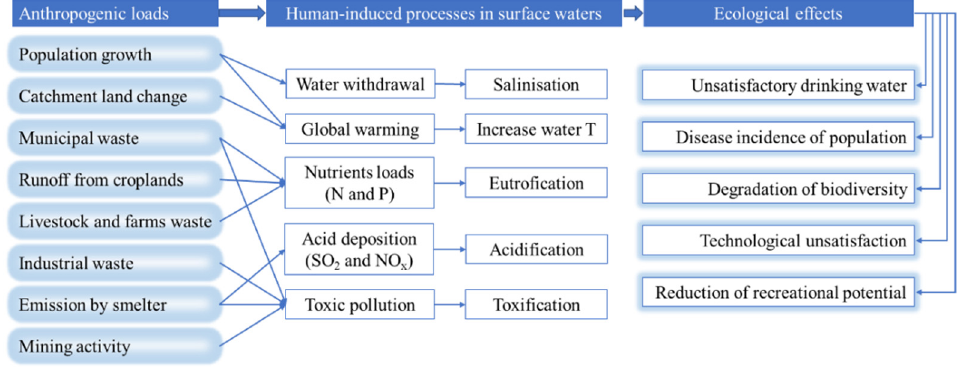
Figure 1. Flowchart showing anthropogenic loads on surface water and its consequences.